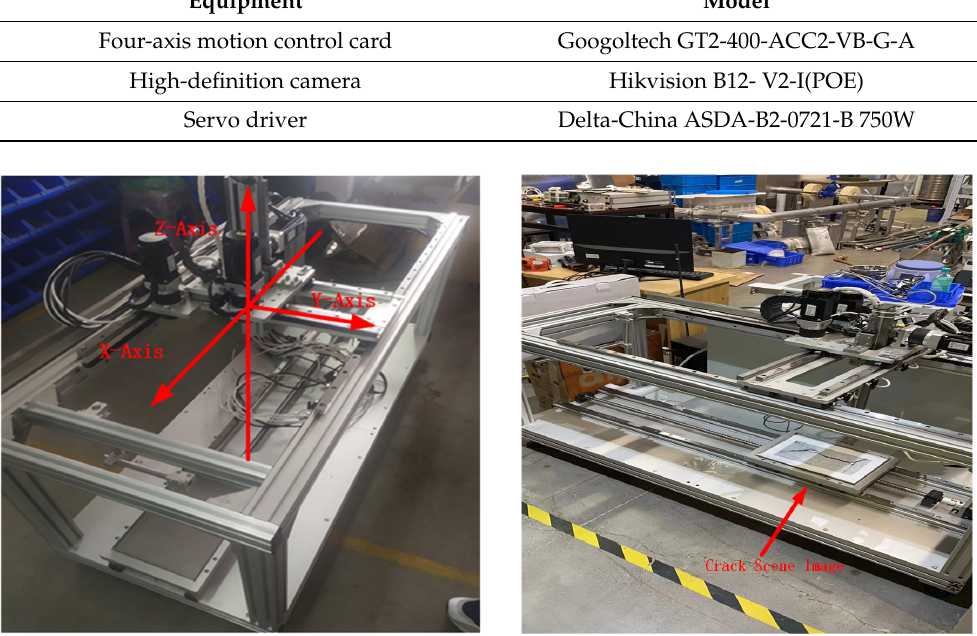
Figure 17. Intelligent pavement crack detection and repair prototype.